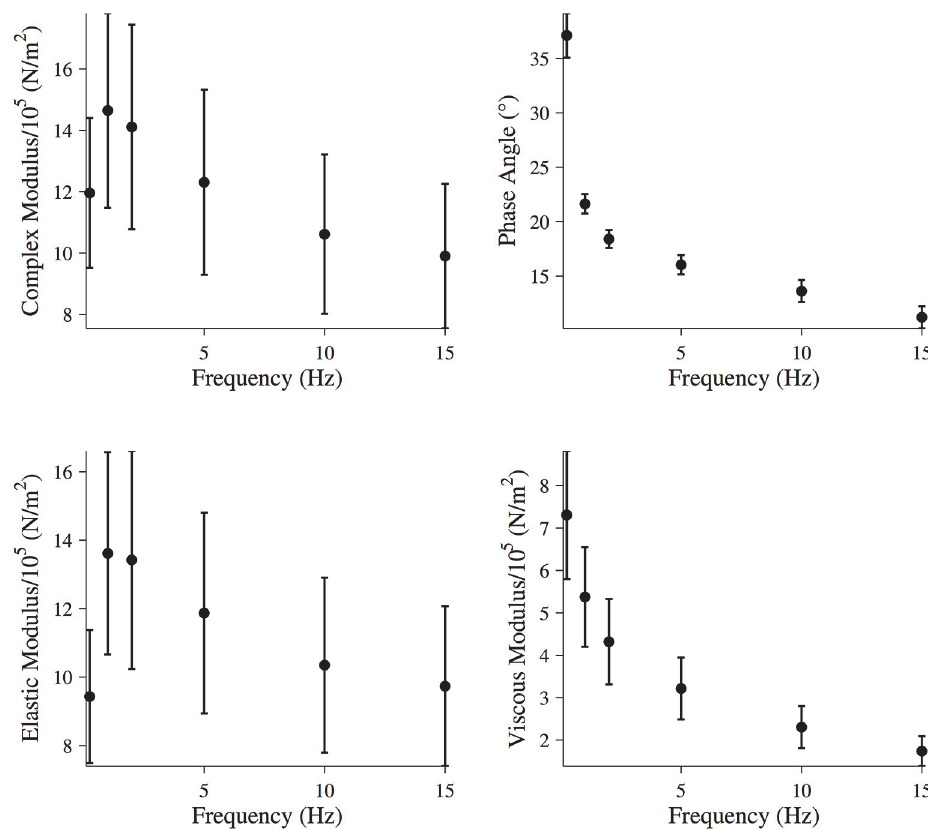
Fig 6. Mechanical properties of activated muscle fibers. Magnitude of the complex modulus, phase, elastic modulus, and viscous modulus for activated muscle fibers during the final five oscillations of the driven oscillation. All data points are (MEAN ± SEM), and the number of fibers analyzed was N = 8.